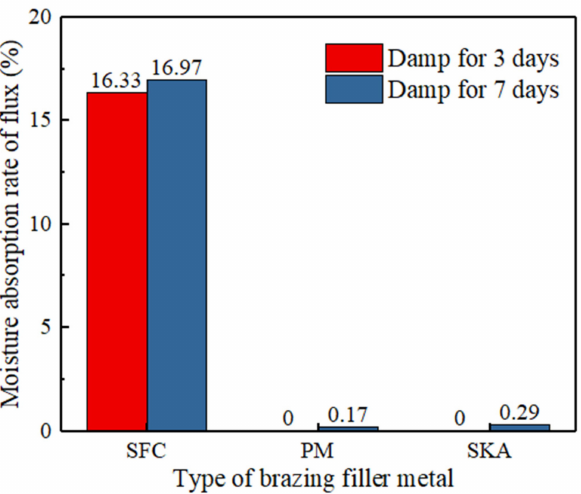
Figure 3. Flux moisture absorption of different brazing filler metals.